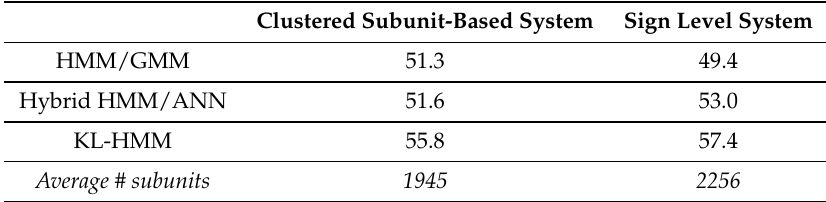
Table 8. Hand movement clustered subunits-based and sign level HMM/GMM, hybrid HMM/ANN and KL-HMM systems performance in terms of recognition accuracy on the SMILE database.